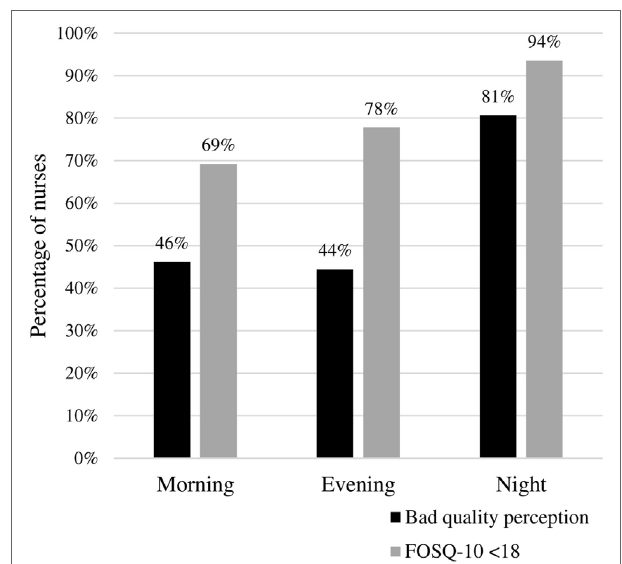
FigUre 2 | Sleep quality comparison between nurses’ work shifts. Night shift nurses had worse sleep quality (perception, p = 0.02; Functional Outcomes of Sleep Questionnaire-10, p =